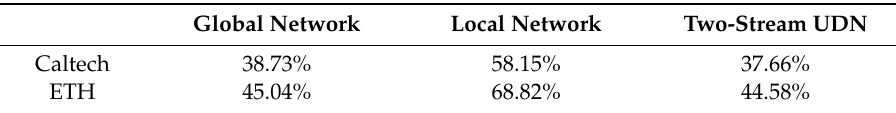
Table 2. LAMR of di ff erent